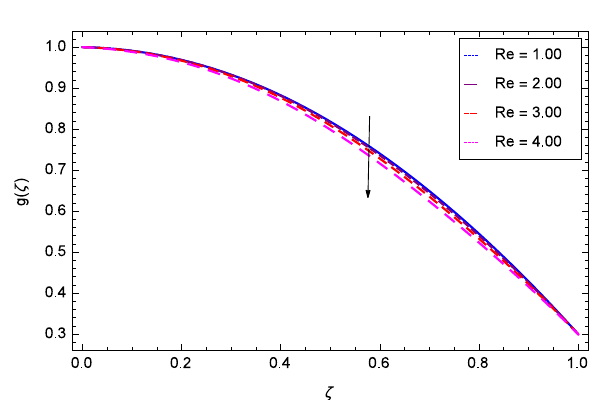
Figure 9. Analysis through rotation parameter (cid:31) and tangential velocity g ( ζ ).